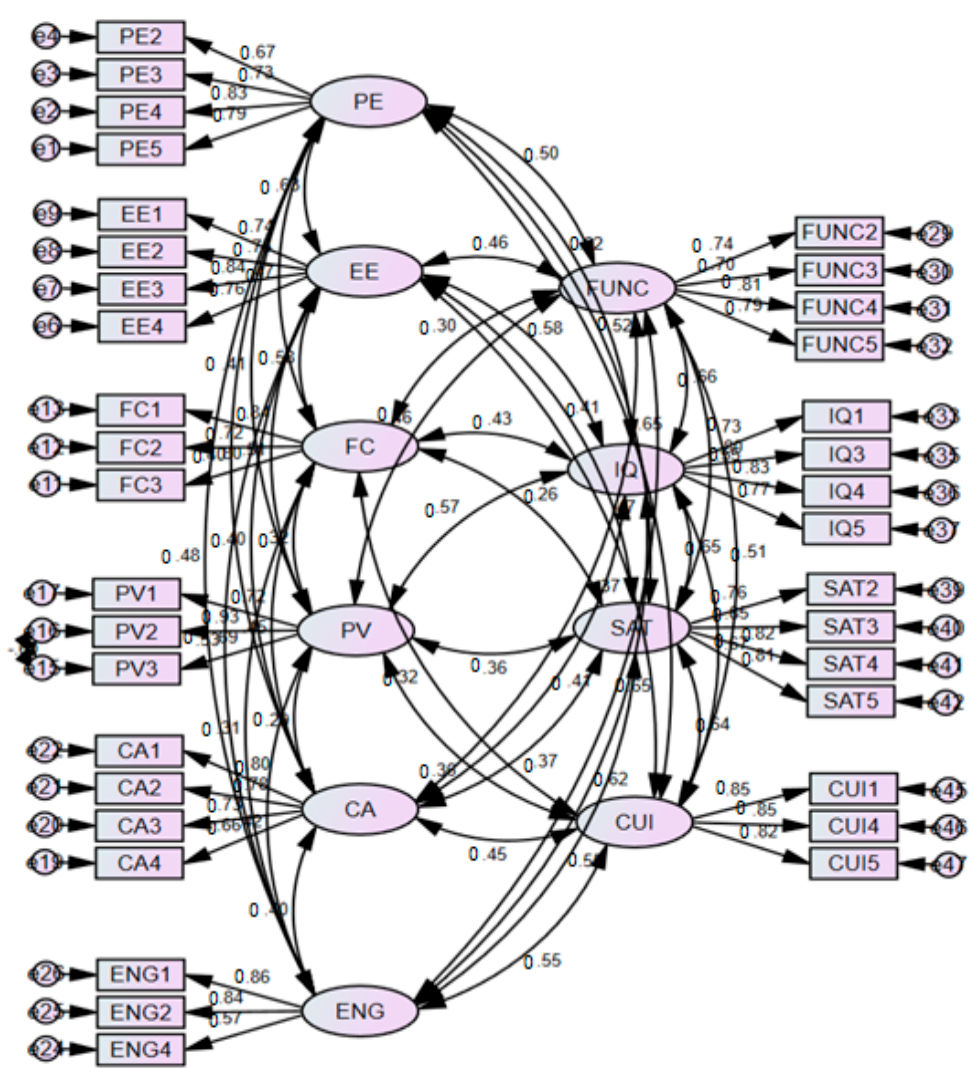
Figure 3. Measurement model.